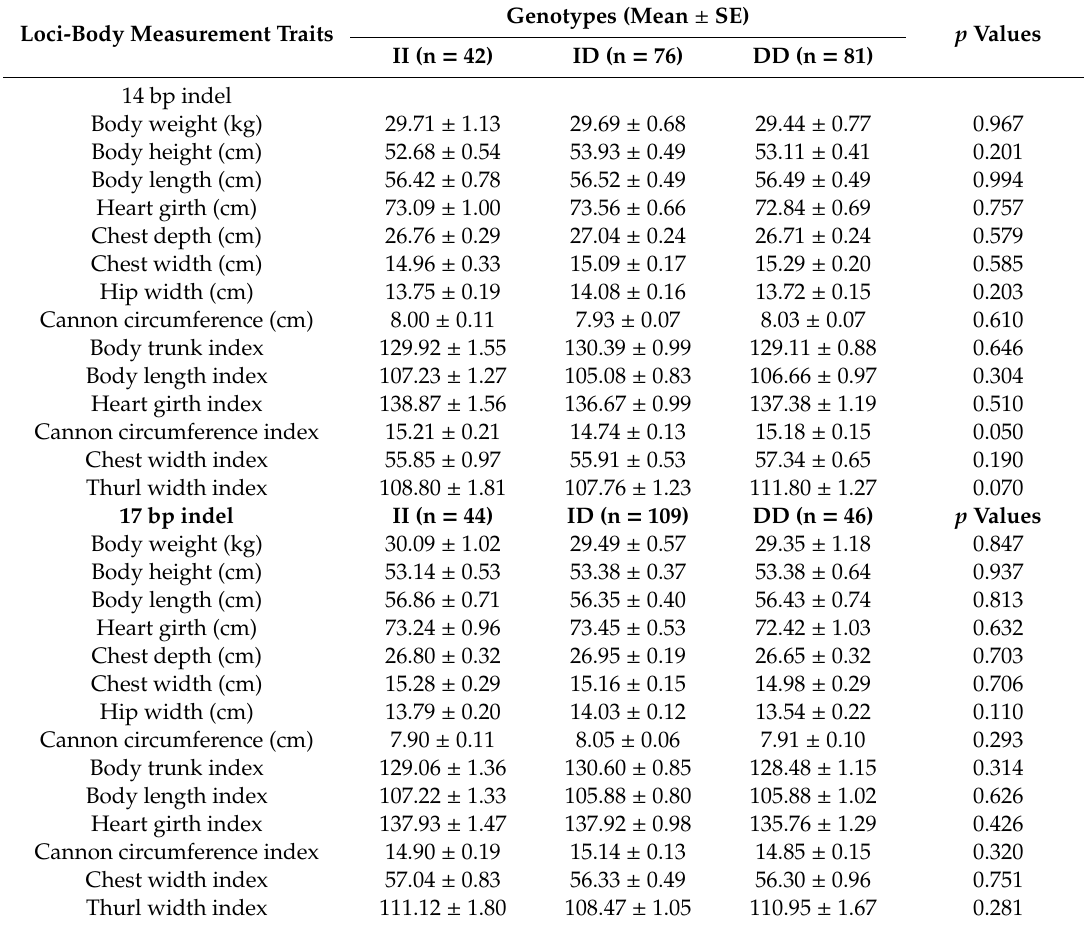
Table 4. The association of SPAG17 14 and 17 bp indels and body measurement traits of Hainan black goats. Loci-Body Measurement